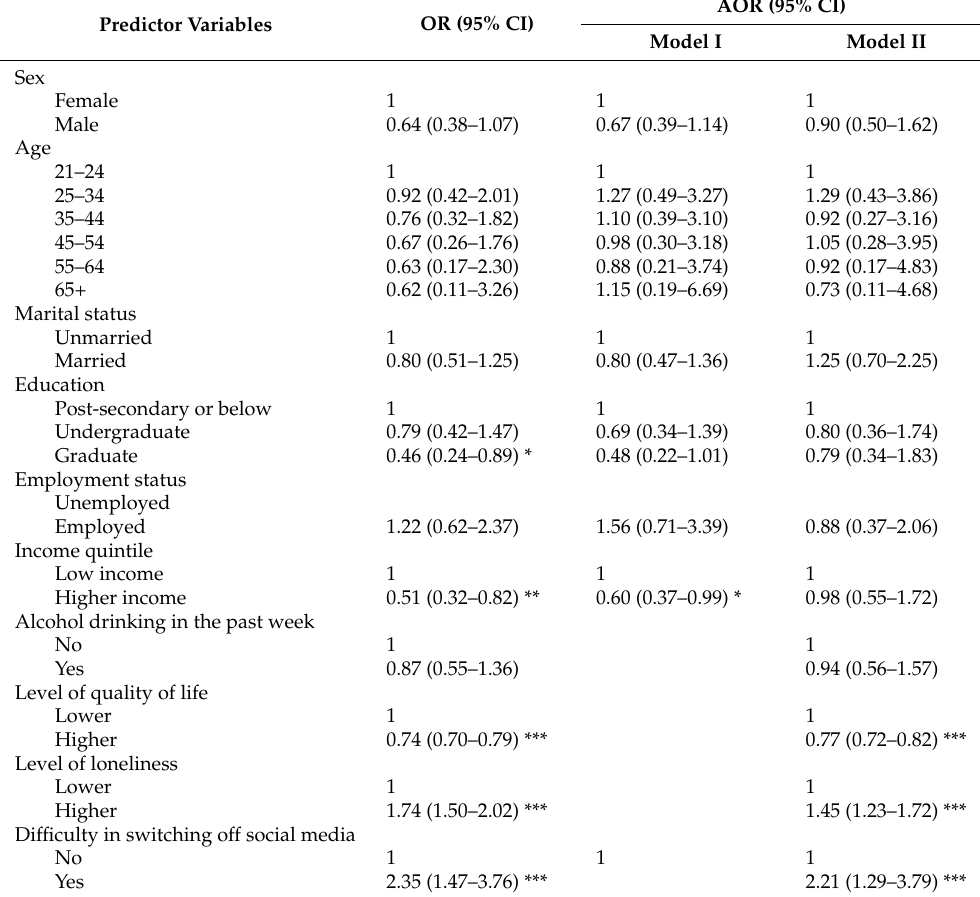
Table 3. Factors associated with anxiety symptom levels (GAD-7) during the COVID-19 pandemic (n =